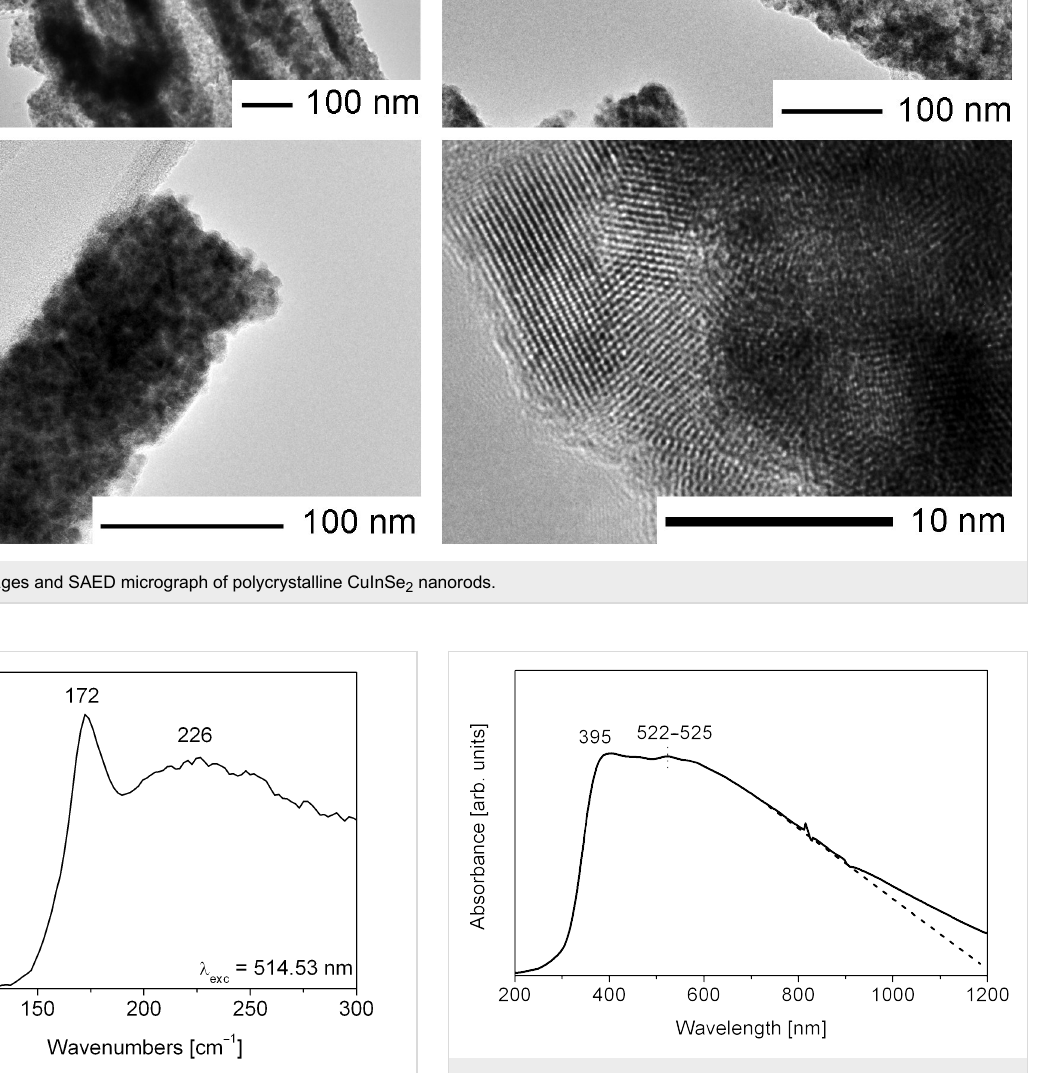
shapes demonstrate a high absorption in the UV region, a maximum peak at 440–540 nm (which corresponds to a band gap of 2.8–2.3 eV) within the visible range, and the absorption spectrum threshold at around 550–900 nm [25,30,31]. In contrast to these examples, our material shows only a moderate absorption in the near ultraviolet region, and practically